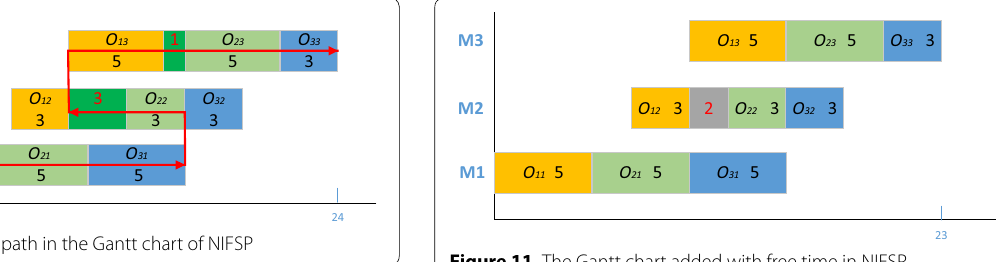
Figure 11 The Gantt chart added with free time in NIFSP